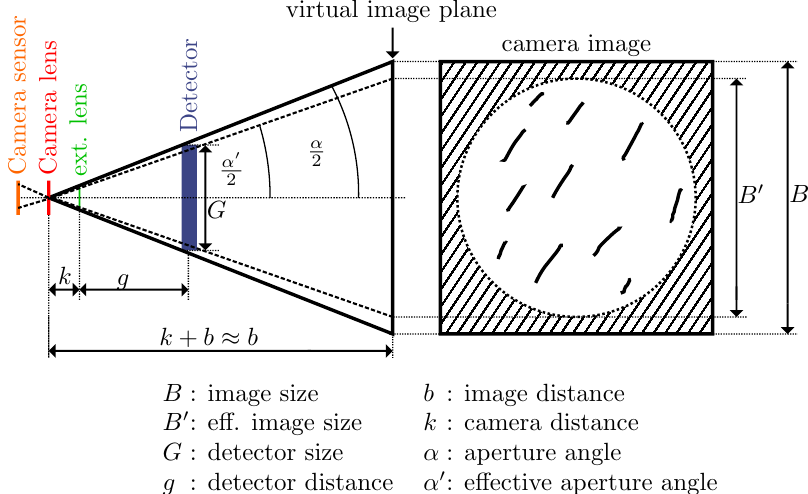
Figure 2. Sketch of the magnifier-based sensor principle: This detector design allows virtual images of Figure 1: Sketch of the magnifier-based sensor principle: This detector design the scatter traces that are created by individual particles traveling through the measurement allows virtual images of the scatter traces that are created by individual particles traveling trhough the measurement volume.